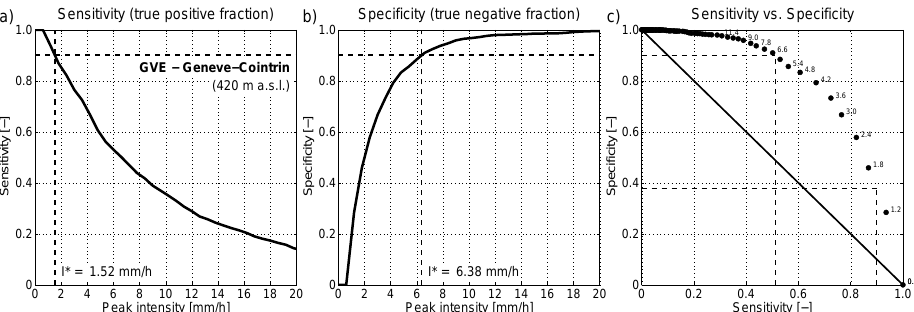
Fig. 6. Estimation of the threshold peak intensity I ∗ on the basis of sensitivity (a) and specificity (b) at station Geneve-Cointrin. The plot (c) shows the inter-relation of sensitivity and specificity at the same station. The numbers within the plot indicate the corresponding value of peak intensity in mmh − 1 .